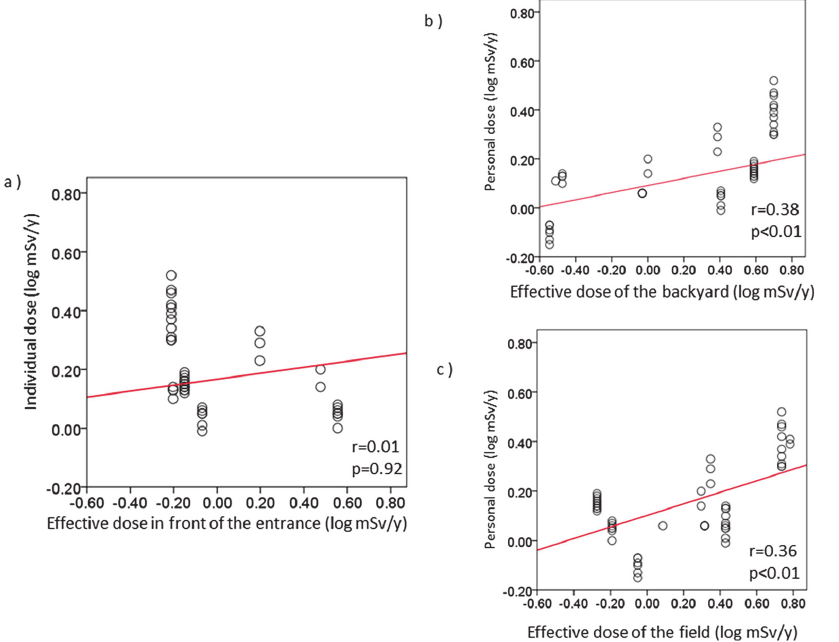
Fig 5. Relationship between individual doses and effective doses from soil